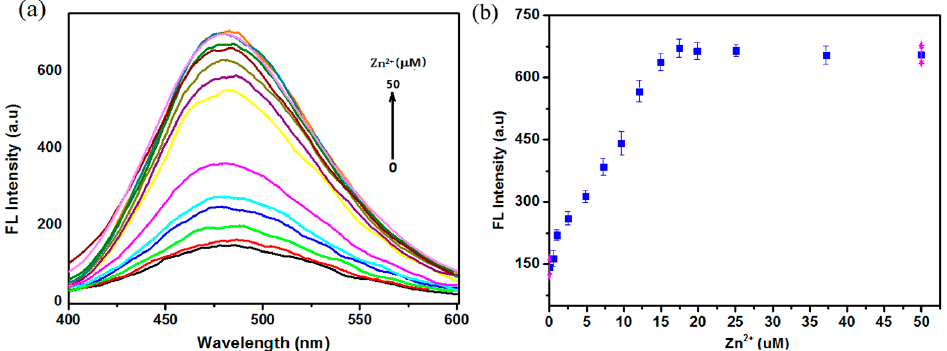
5 of 9 Figure 2. ( a ) The FL intensity of TPE-2triazole-2CD (50 μ M) in DMSO/H 2 O (2/3, v / v ) in the presence of 5 equivalent of different metal ions; ( b ) Fluorescence response of the sensor (50 μ M) to 0.5 equivalent of metal ions (the green bar) and to the mixture of 0.5 equivalent of other metal ions with 0.5 equivalent of Zn 2+ (the blue bar) and the fluorescence response of TPE-2triazole-2CD toward Zn 2+ + all metal ions (the red bar) ( λ ex = 330 nm, λ em = 478 nm). In order to figure out the binding stoichiometry between Zn 2+ and the sensor, fluorescence titration was conducted in this study (Figure 3). It was discovered that the FL intensity of TPE-2triazole-2CD is almost linearly accentuated by increasing the Zn 2+ concentration from 0 to 17.5 μ M and levels off after Zn 2+ concentration reaches 17.5 μ M. As the TPE-2triazole-2CD concentration was 50 μ M, the fluorescence titration results and the Job’s plot (Figure S6 ESI † ) indicate the binding stoichiometry between TPE-2triazole-2CD and Zn 2+ should be 3:1. In order to conduct further investigation on the aggregation of TPE-2triazole-2CD upon the addition of Zn 2+ , particle size distribution analysis (Figure S7 ESI † ) and transmission electron microscopy (TEM) (Figure S8 ESI † ) measurements were also performed. It was found that the particle size of TPE-2triazole-2CD in DMSO/H 2 O was significantly increased by addition of Zn 2+ and the aggregation can participate from the solution at higher sensor concentration which is clearly visible without excitation by UV (Figure S9 ESI † ). The remarkably changed morphology of TPE-2triazole-2CD before and after addition of Zn 2+ reveals the diversification of the micro-environment on the addition of Zn 2+ . The above results indicate that the sensing process of TPE-2triazole-2CD towards metal ions should be realized by the binding caused aggregation to turn on its fluorescence based on the restricted intramolecular rotation (RIR) mechanism. We have already known that water can form a bridge between the hydroxyl groups of adjacent molecules of CD to induce aggregation [39]. By controlling the water fraction and sensor concentration, the pre-aggregation effects and the rigid structure can provide